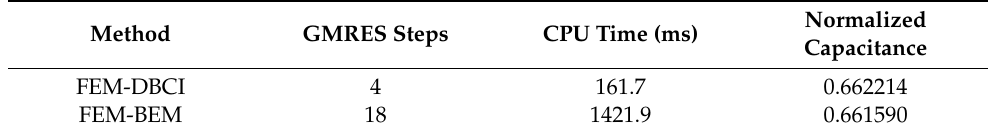
Table 3. Comparison between FEM-DBCI and FEM-BEM for the 3rd example.